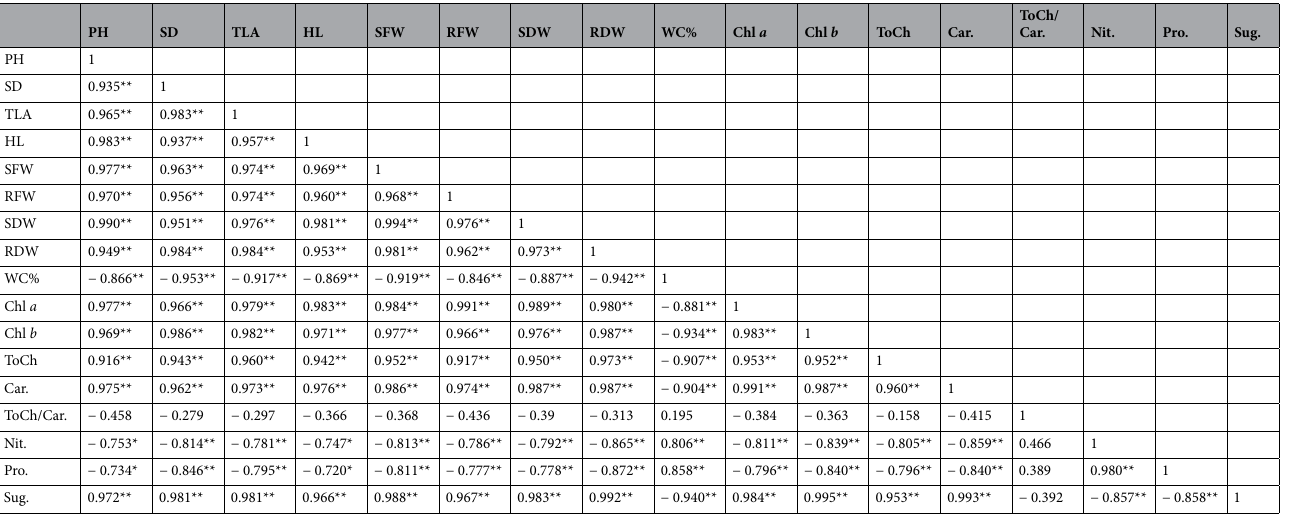
Table 3. Correlation coefficient evaluation between studied traits in cucumber seedlings. *Correlation is significant at the P ≤ 0.05 level. **Correlation is significant at the P ≤ 0.01 level, by using Pearson correlation coefficients. Where PH Plant height, SD Stem diameter, TLA Total leave area, HL Hypocotyl length, SFW Shoot fresh weight, RFW Root fresh weight, SDW Shoot dry weight, RDW Root dry weight, WC% Water content, Chl a Chlorophyll a , Chl b Chlorophyll b , ToCh Total Chlorophyll contents, Car. Carotenoid, ToCh/Car. Total Chlorophyll contents/Carotenoid, Nit. Nitrate content, Pro. Protein content, and Sug. Sugar